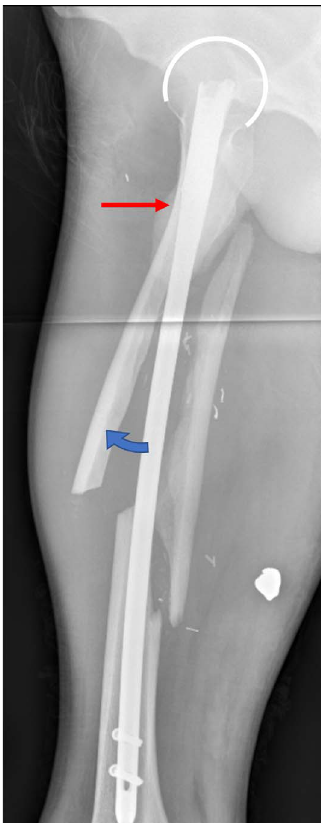
Figure 4. Image is a lateral femur X-ray with a cephalomedullary nail resulting in fracture displacement irrespective of implant placement aligned with the femur neck. The red arrow illustrates proximal anterior femur abutment, and the bottom blue arrow illustrates the ensuing